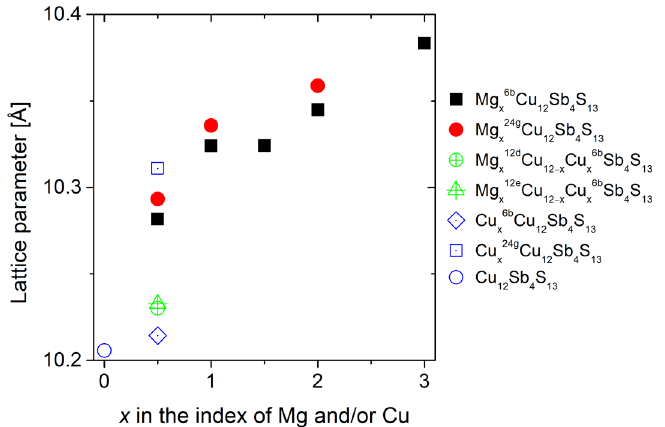
Figure 3. Calculated lattice parameters of Mg x Cu 12 Sb 4 S 13 and Cu 12+x Sb 4 S 13 . The upper indexes indicate the position of the atom in the structure for which calculations were carried out. If not indicated, Cu, Sb and S occupy their nominal positions, i.e., 12d/12e, 8c, 24g/2a, respectively.